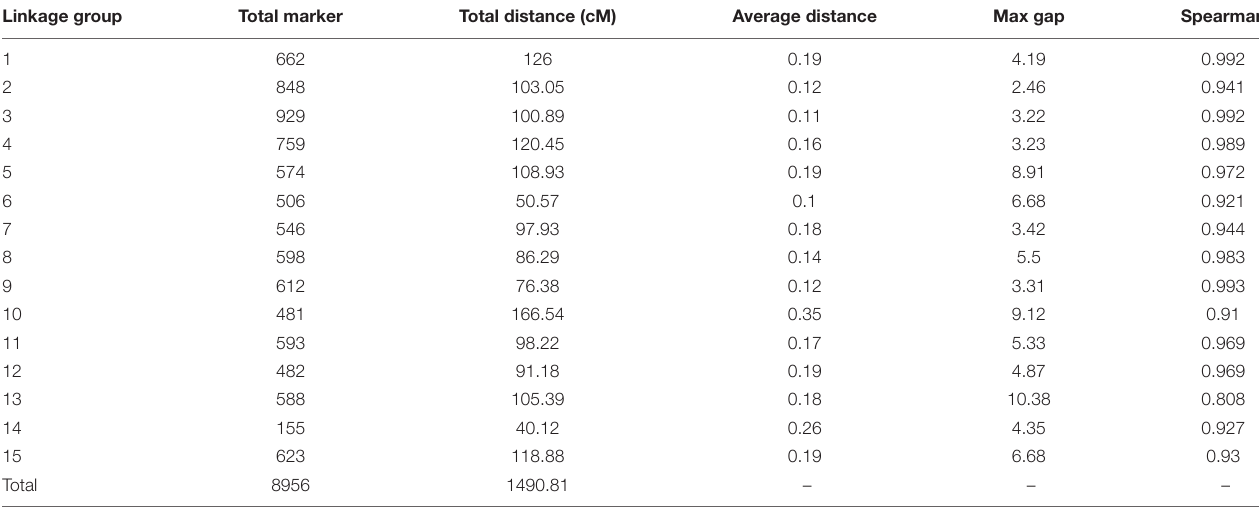
TABLE 1 | Information on the newly constructed genetic map.